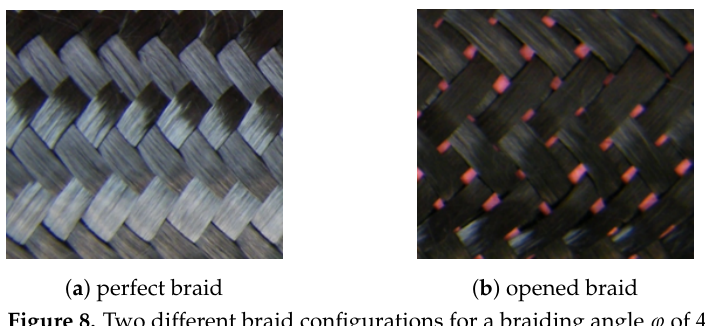
Figure 8. Two different braid configurations for a braiding angle ϕ of 45 ◦ .